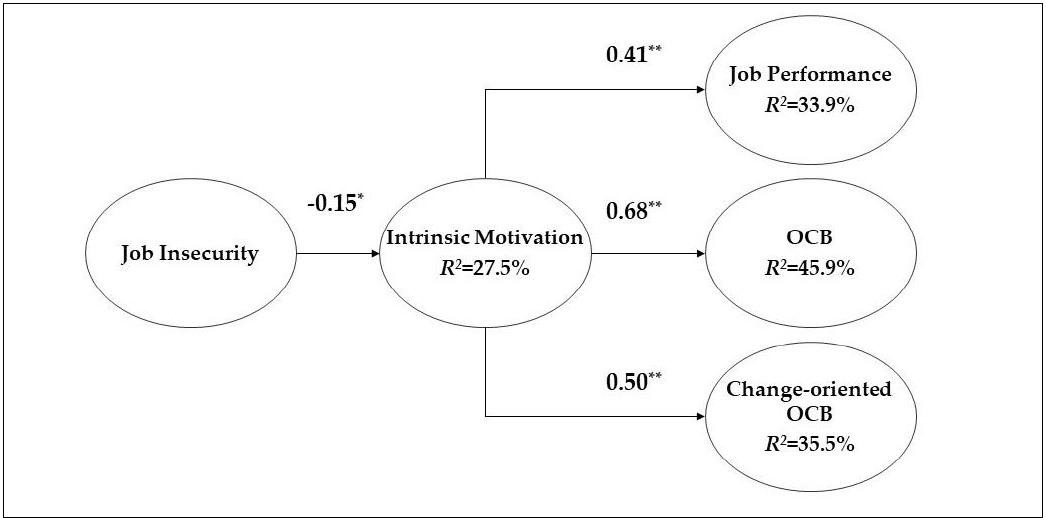
< 0.05, ** p < 0.01. Path